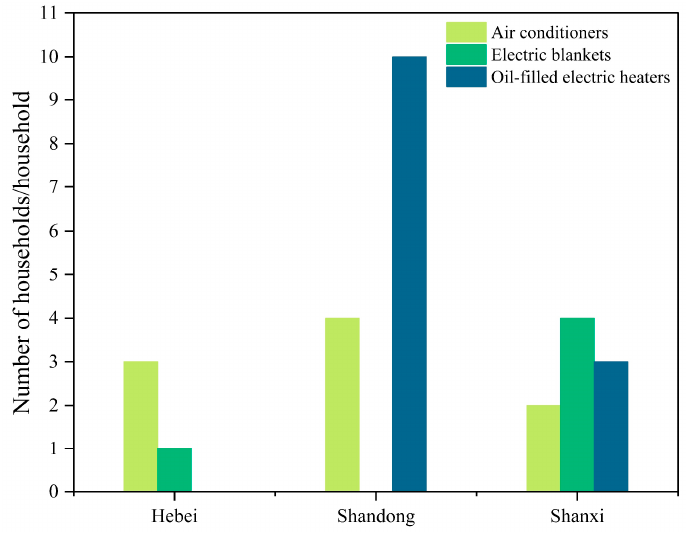
Figure 3. The use of auxiliary heating equipment.